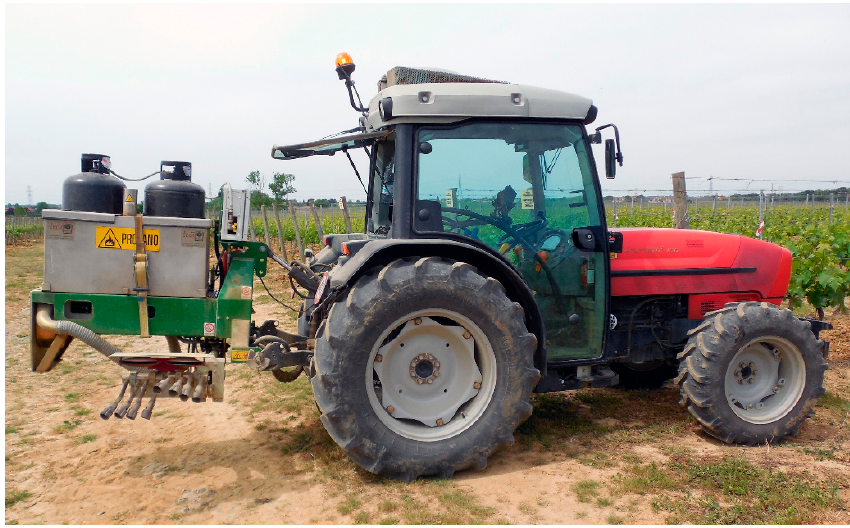
Figure 2. The flaming machine PFV-600 (Officine Mingozzi, Ferrara, Italy) coupled with a SAME Frutteto 100 (SAME, Treviglio, Italy) tractor.